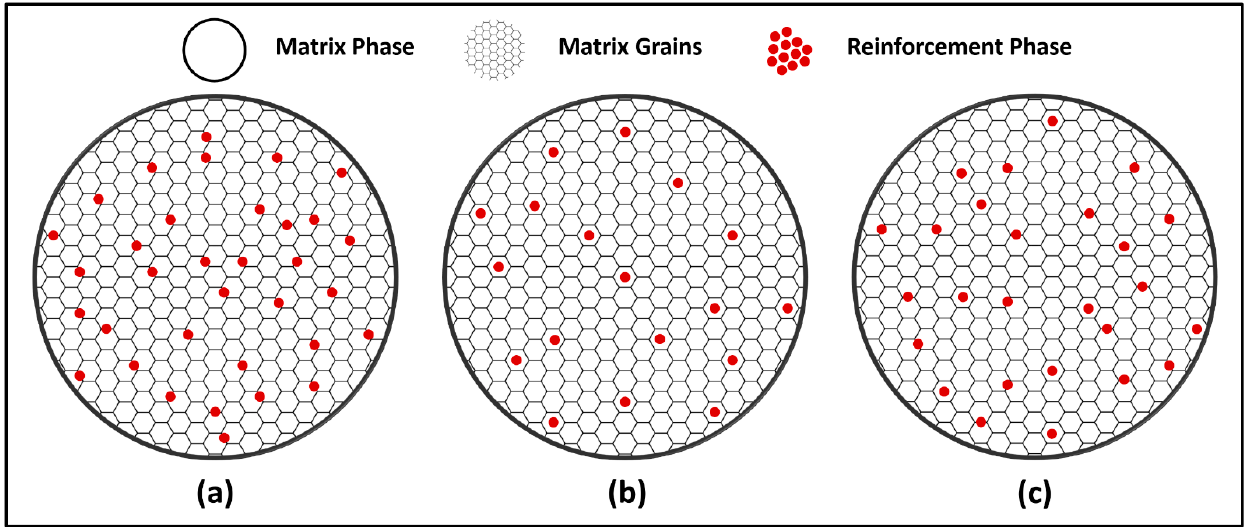
Figure 3. Schematic representing the possible distribution patterns of the reinforcement phase within the matrix in an MMC: ( a ) distribution of reinforcement phase along the grain boundaries of matrix; ( b ) distribution of reinforcement phase inside the grains of matrix; and ( c ) combined distribution pattern of both ( a , b ).